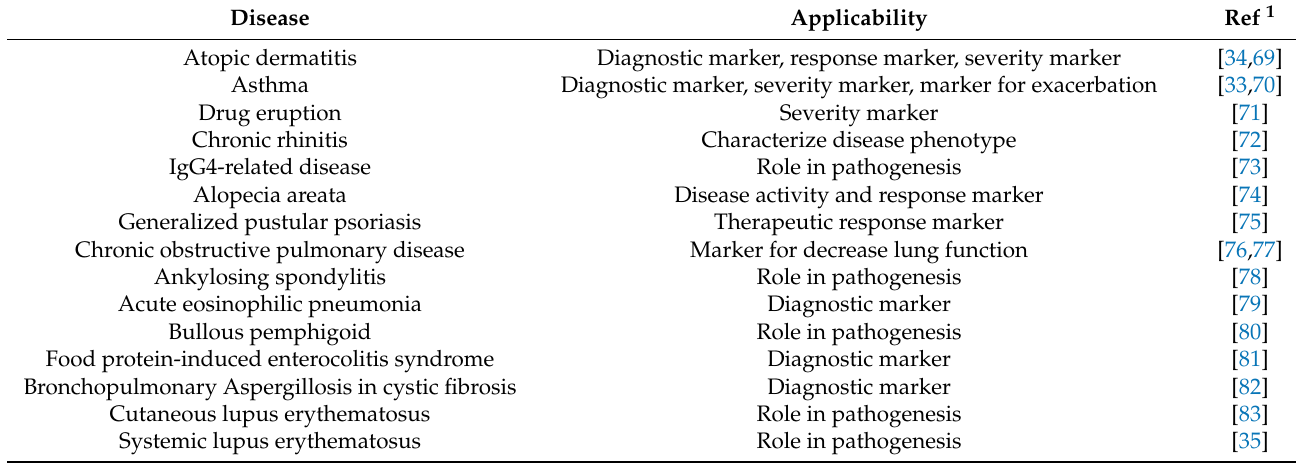
Table 2. Potential applicability of TARC in non-oncological